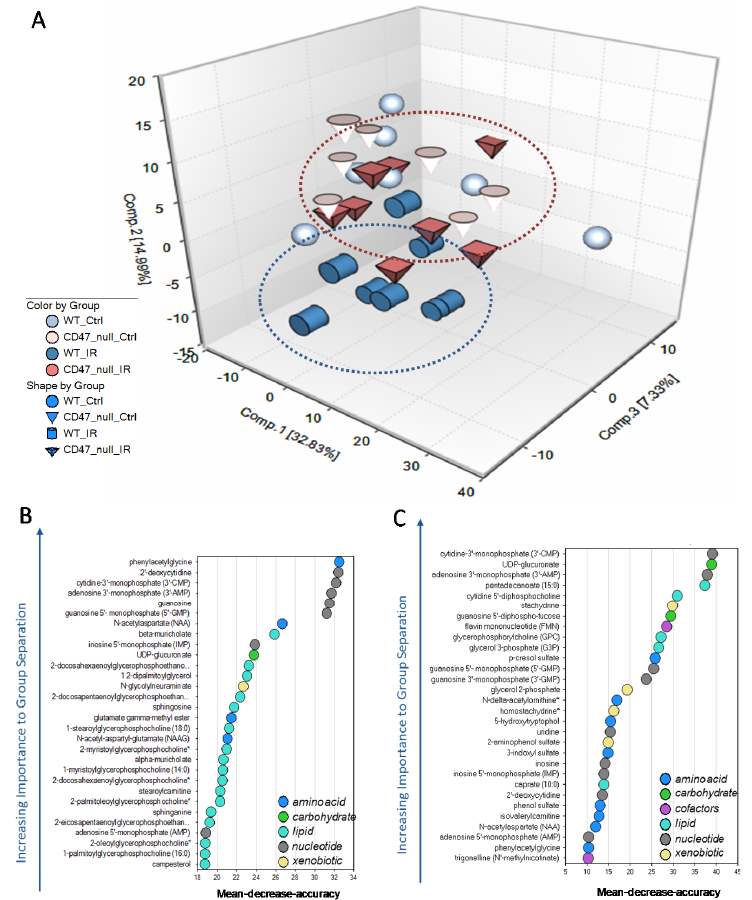
Figure 1. WT and cd47 null mice demonstrate different biochemical signatures after exposure to ionizing radiation. WT and cd47 null mice were left untreated or were exposed to whole body irradiation (7.6 Gy). After 24 h, lungs were harvested and processed for metabolomic analysis. ( A ) Principal component analysis of lung tissues of WT and cd47 null mice with or without exposure to whole body irradiation. Random forest analysis of ( B ) WT irradiated or ( C ) cd47 null lung irradiated tissues. n = 7–8/group.